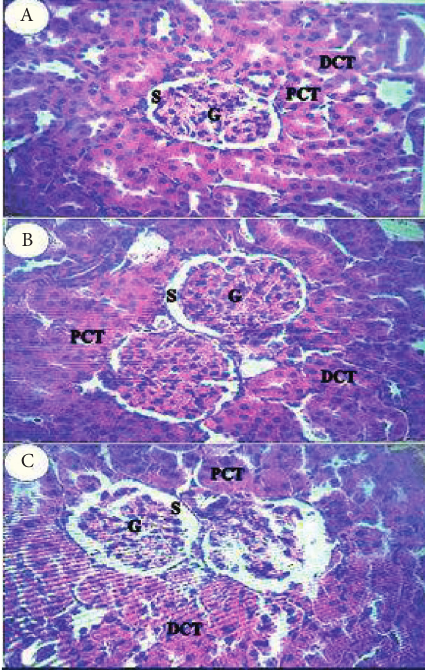
Figure 5: Kidneys histological sections with hematoxylin and eosin stain (200x) obtained from control rats (a), rats treated with ODSO and gentamicin (b), and rats with gentamicin (c). G, glomeruli; S, Bowman space; PCT, proximal convoluted tubules; PDT, distal convoluted